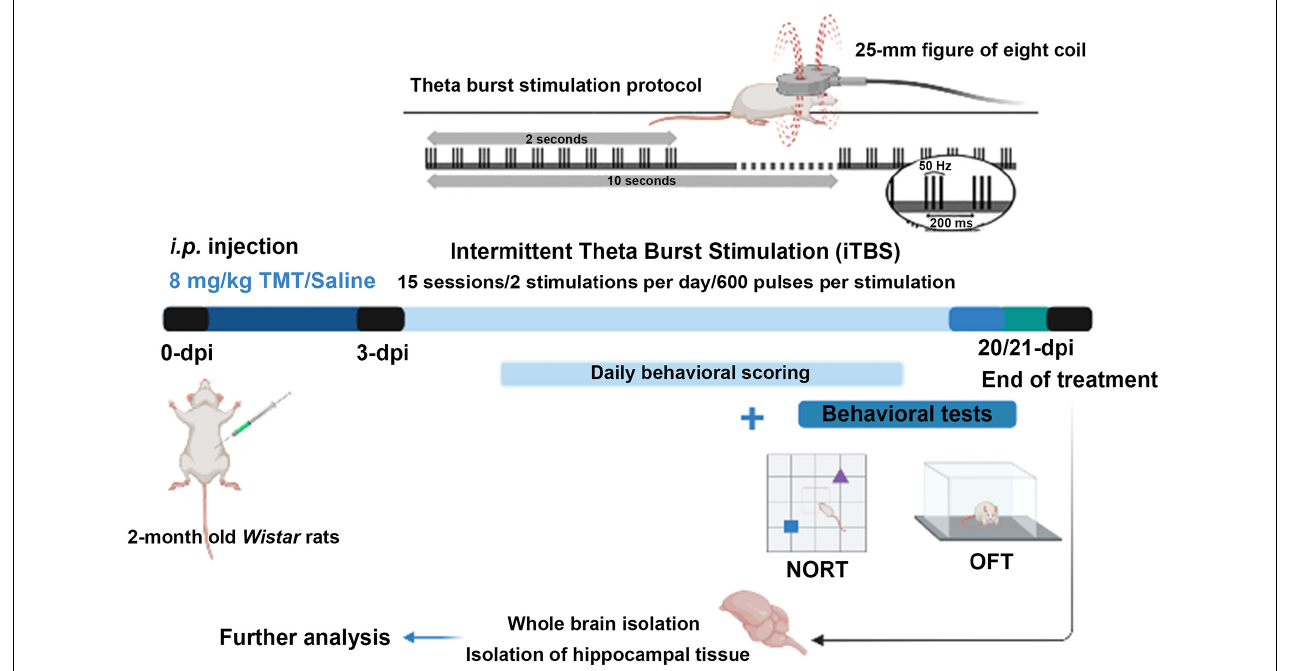
FIGURE 1 | Experimental design diagram. On day 0, animals of the TMT, TMT + iTBS, and TMT + iTBS sham group received a single intraperitoneal injection of TMT (8 mg/kg dissolved in 0.9% saline). The control group received an adequate volume of saline solution. The animals were daily scored for signs of unusual behavior for 3 weeks. Intermittent theta-burst stimulation (iTBS) was applied on 3-dpi using MagStim Rapid 2 device and a 25-mm figure-of-eight coil. Applied iTBS protocol consisted of 20 trains of ten bursts (3 pulses at a frequency of 50 Hz), repeated at 5 Hz (10 s intervals between trains, total duration of the procedure is 192 s), twice a day for 15 days in total. On the 20-/21-dpi, the behavior was evaluated by using the open field test (OFT) and novel object recognition (NORT) tests. After behavioral tests, animals were sacrificed. Whole brains and hippocampal tissue were isolated for immunohistological and immunoblot analyses.